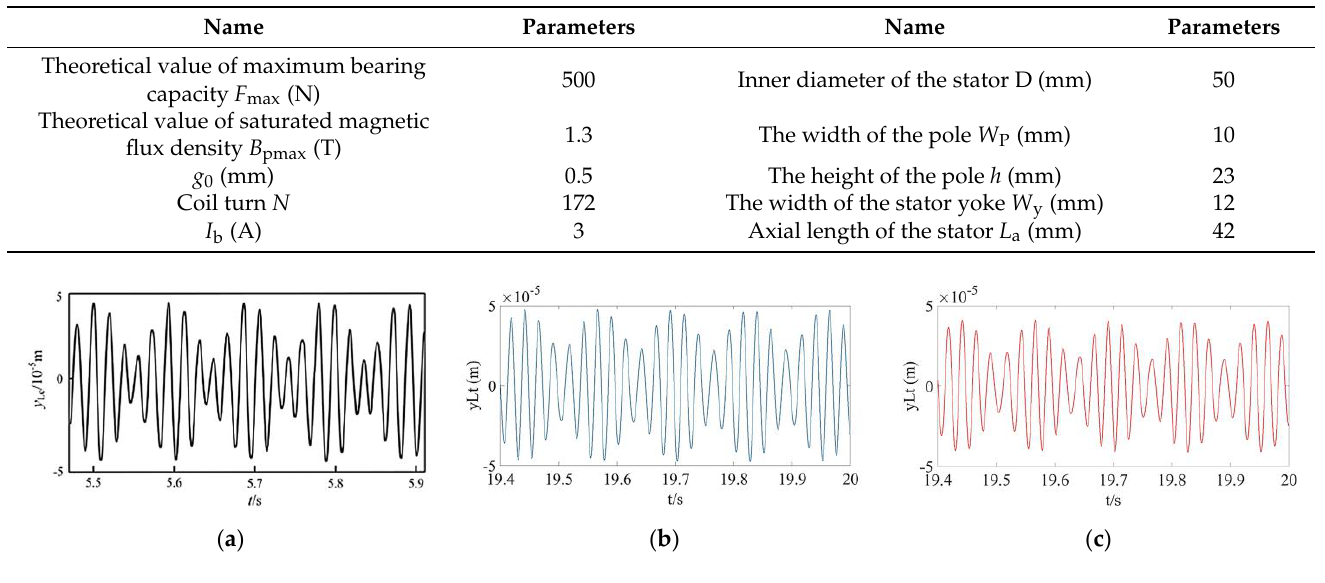
Figure 7. Displacement response of the dual-rotor system ( ω i = 252.6 rad/s; ω o = 301.2 rad/s). ( a ) Yang’s experimental result; ( b ) numerical result of the conventional MSDS; ( c ) numerical result of the nonlinear MSDS.